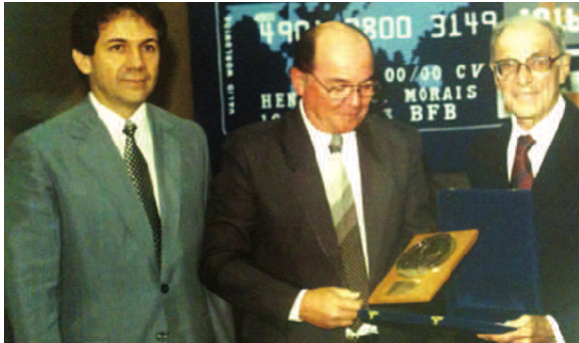
Fig. 4 – Prof. Zerbini e Prof. Ricardo Lima homenageiam o